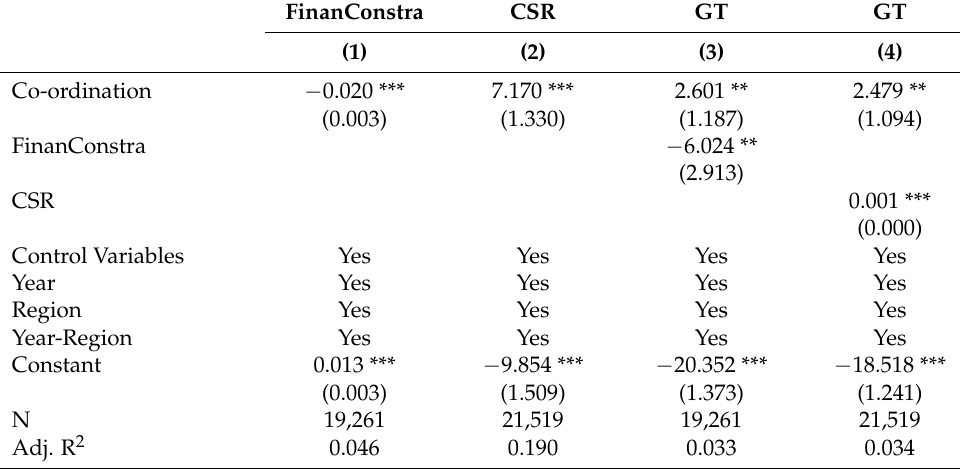
Table 8. Mechanism test of HQCD on screening effect of green